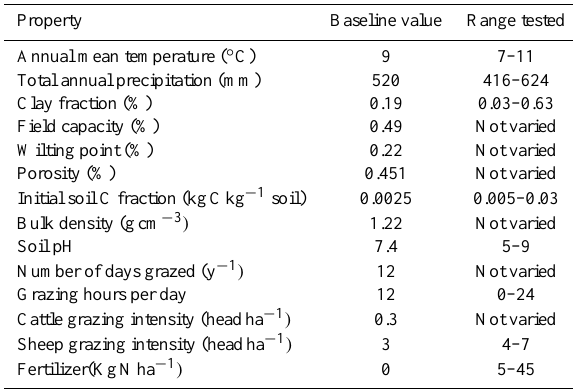
Table 1. Selected statistics for comparison of observed and simu-